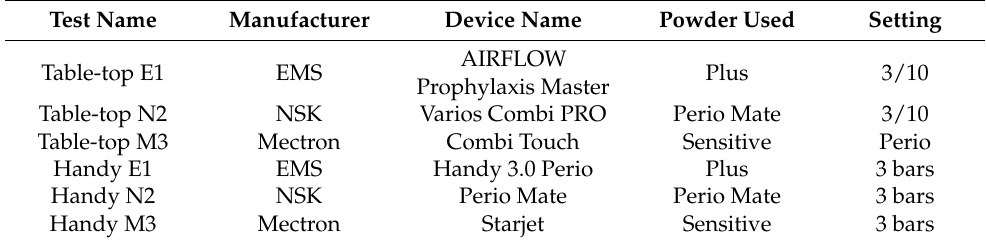
Table 1. Devices used for this